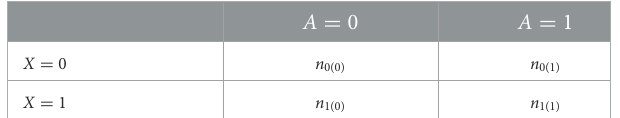
TABLE 1 Data table for Example